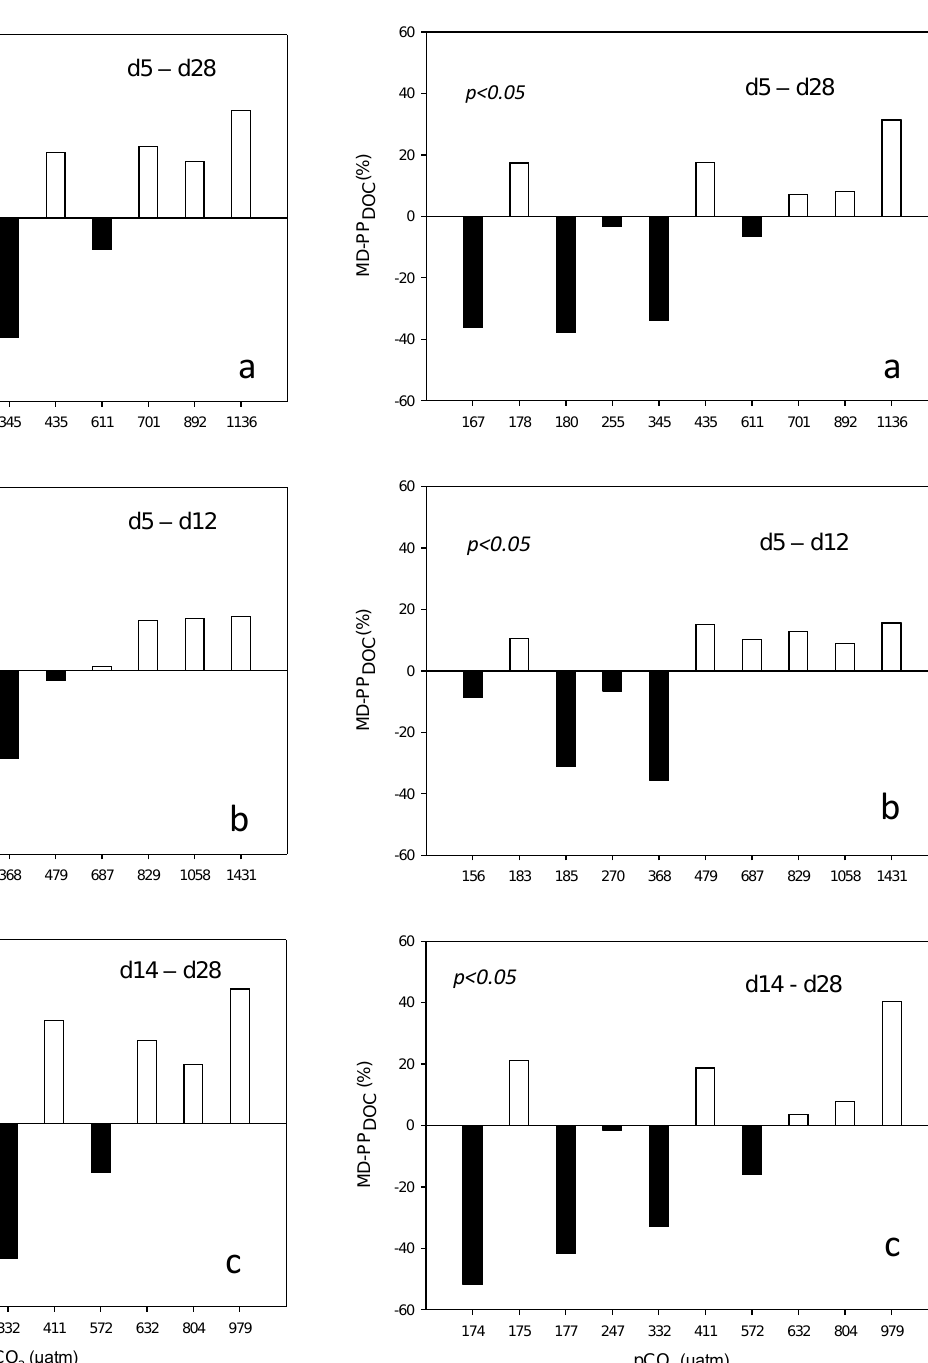
Fig. 9. Mean deviations of PP DOC (MD-PP DOC , %) for the nine mesocosms and for the fjord (left bar) calculated for (a) the total period of observation (day 5–day 28; n = 12), (b) the period before nutrient addition (day 5–day 12; n = 4), and (c) the period after nu- trient addition (day 13-day 27; n = 8). Significance of relationship between MD-PP DOC and average p CO 2 at the time of observation was calculated by linear